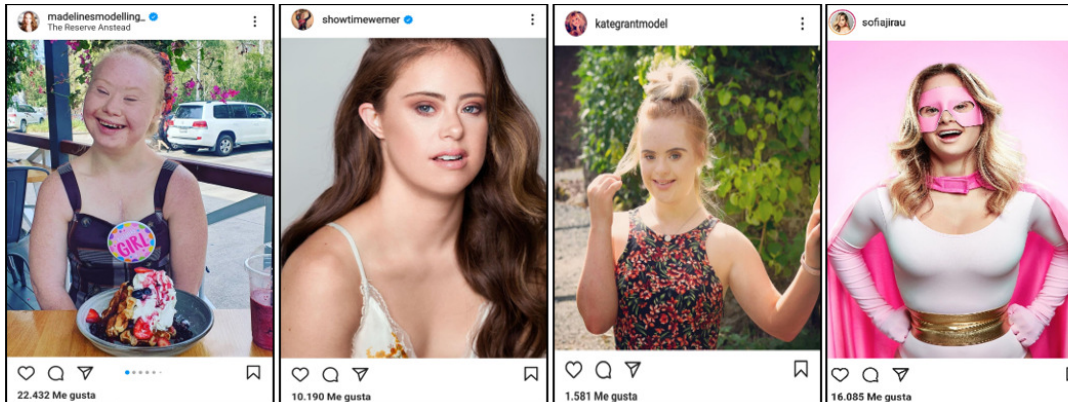
Figure 1. Beauty, fashion, and health categories.